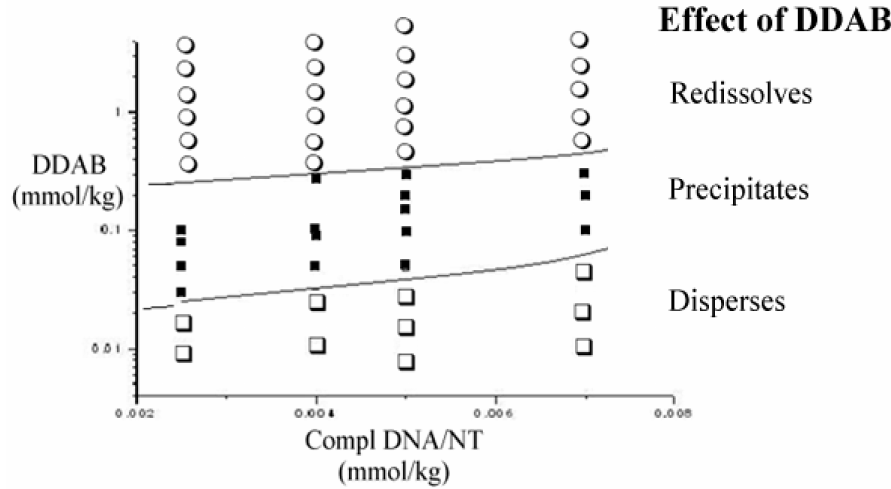
Figure 2. Dependence of ζ -potential values, at 25.0 °C, on the nominal charge ratio between complexes and DDAB. The white symbol indicates charge neutralization, the grey area is the instability regime. The accuracy on the individual points is within the symbols’ size; the line is for visual purposes.